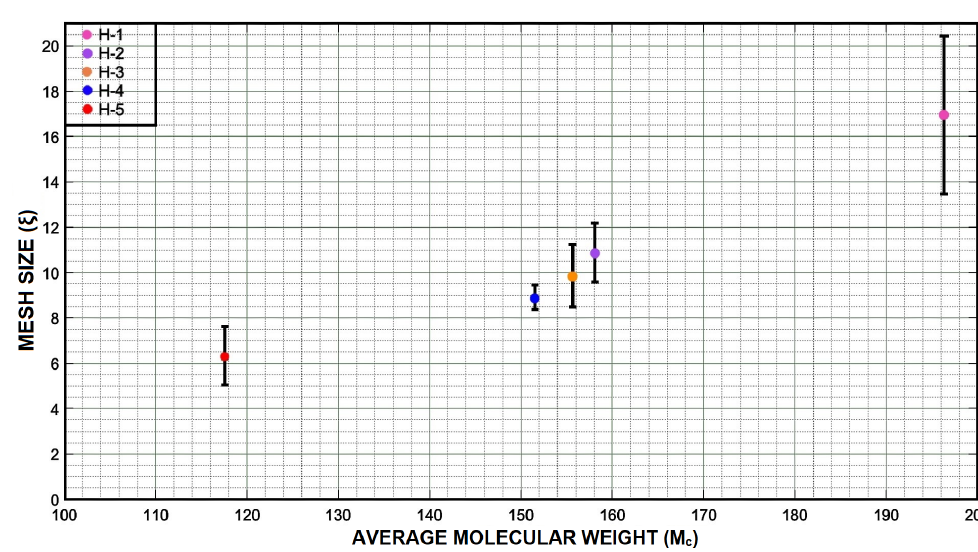
Figure 18. A graphical comparison between M c values and ξ values shows the close relationship that both values have with the amount of cross-linking agent used in different hydrogel